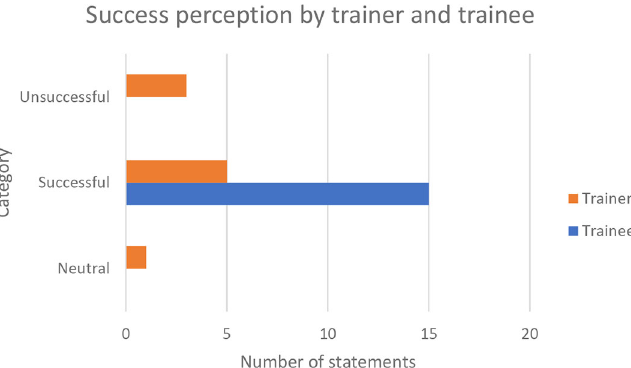
Figure 1. Training success perception by trainer and